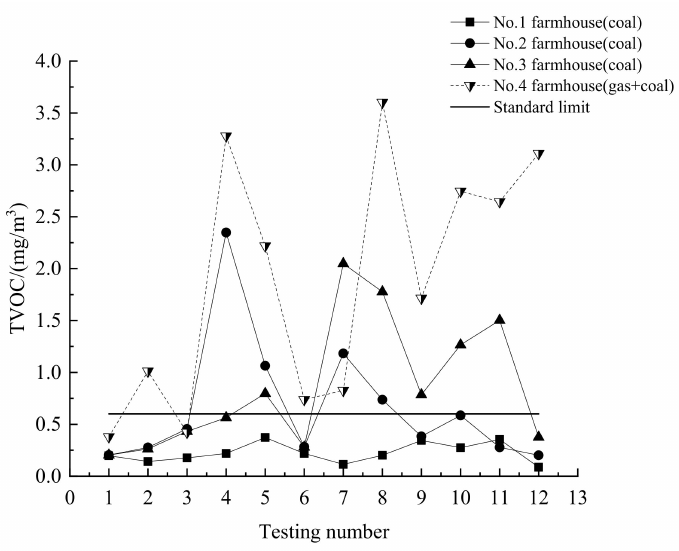
Figure 6. Content changes of TVOC in coal-fired